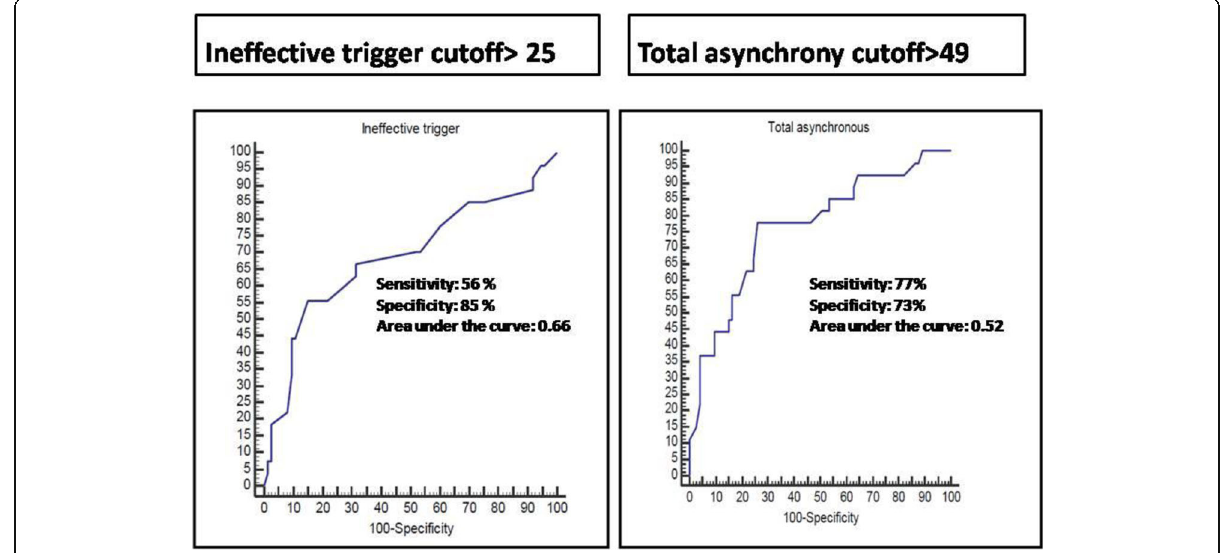
Fig. 3 Sensitivity and specificity of an ineffective trigger and total asynchrony on predicting weaning